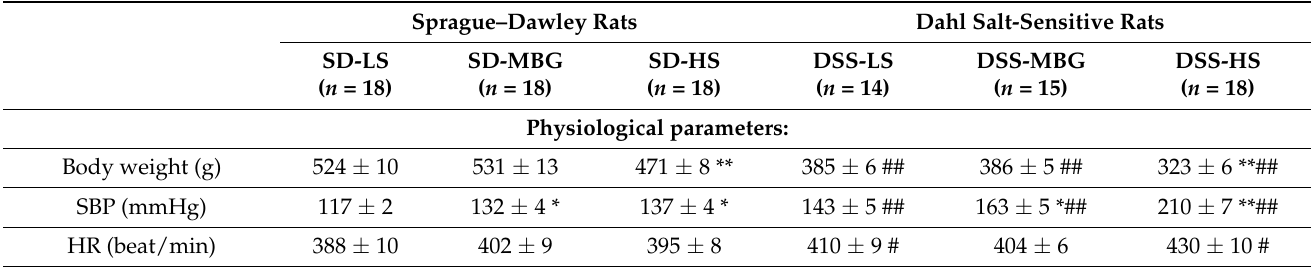
Table 1. Basic parameters in Sprague–Dawley rats and Dahl salt-sensitive rats following a low-salt (LS) diet, marinobufagenin (MBG), or a high-salt (HS) diet